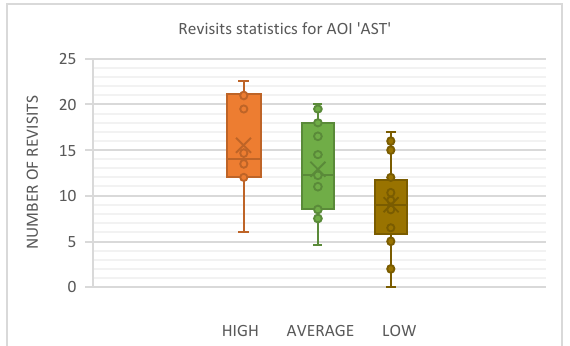
Figure 20 . Box plot for the number of revisits inside AOI